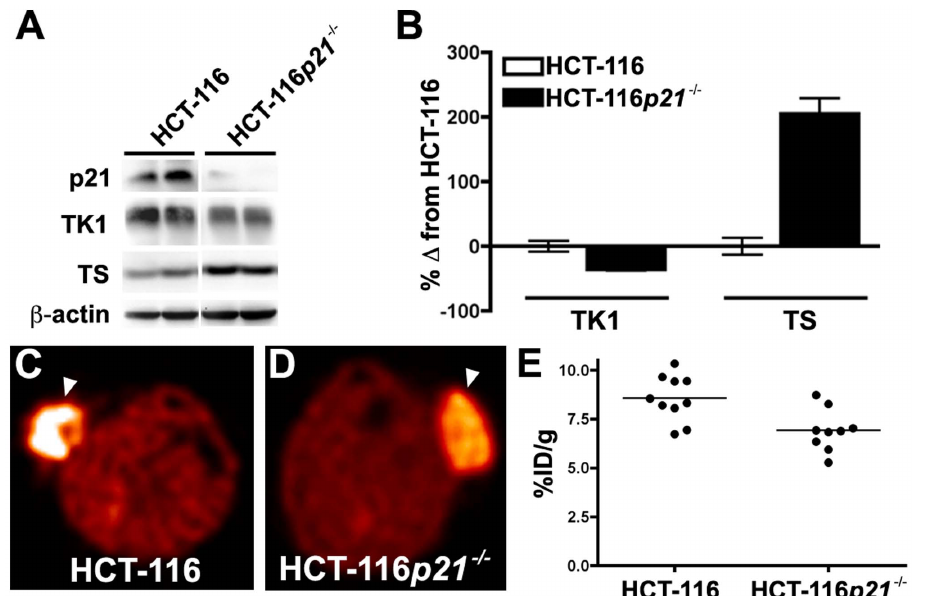
Figure 5. Isogenically matched cell line xenografts illustrate that denovo pathway utilization results in decreased [ 18 F]-FLT uptake. Western blot analysis illustrated reduced TK1 levels and elevated TS levels in HCT-116 p21 -/- xenografts compared to wild type HCT-116 xenografts (A). Densitometry of the western blot illustrated that HCT-116 p21 -/- tumors exhibited one-third less TK1 protein and double the TS protein compared to the parental line (B). Illustrating the sensitivity of [ 18 F]-FLT PET to de novo pathway utilization, PET imaging of HCT-116 (C) and HCT-116 p21 -/- (D) xenografts closely reflected the relative tumor cell TK1 levels inherent to each model (tumor localized by arrowhead). HCT-116 xenografts (8.56 6 1.17 %ID/g) exhibited approximately 1/3 greater uptake than analogous HCT-116 p21 -/- xenografts (6.91 6 1.07 %ID/g; p = 0.005) (E).